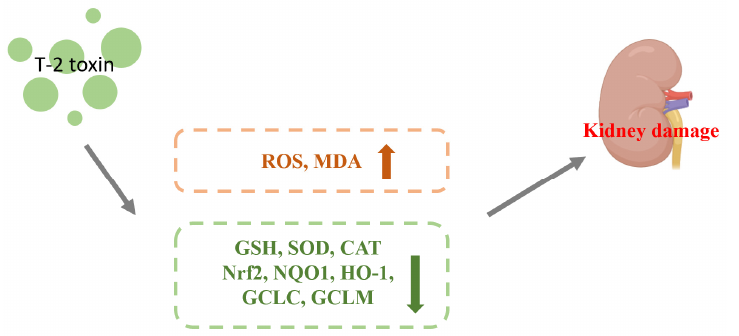
Figure 3. Mechanism of nephrotoxicity induced by T-2 toxin. T-2 toxin causes T-2 toxin leads to increased ROS and MDA contents and decreased expression of GSH, SOD, CAT, Nrf2, NQO1,